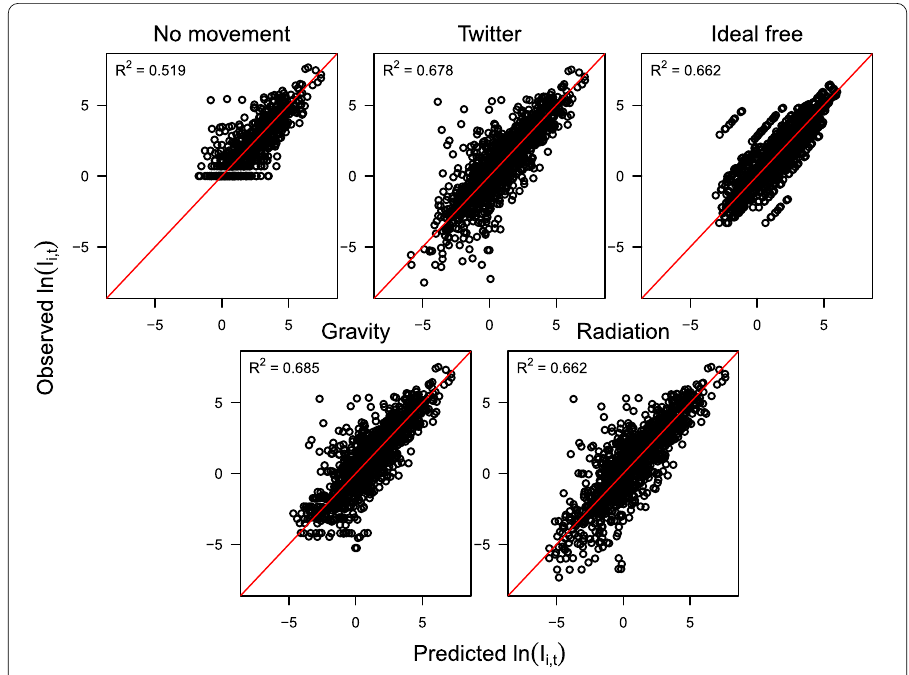
Figure 4 Relationships between predicted ( x -axis) and observed ( y -axis) log incidence based on models fitted to five different mobility-based incidence time series (panels). The coefficient of determination, R 2 , associated with each best-fit model is indicated in each panel. Values of observed incidence vary across panels due to the effect of different assumptions about mobility used to transform the residence-based time series to mobility-based time series. For example, log incidence under the assumption of no movement never falls below 0, because there were no fractional cases observed in the raw data. Fractional incidence did occur in the other two time series due to each person’s incidence of disease being partitioned across the towns proportional to assumed mobility patterns. Under the ideal free assumption, the diagonal sets of points are